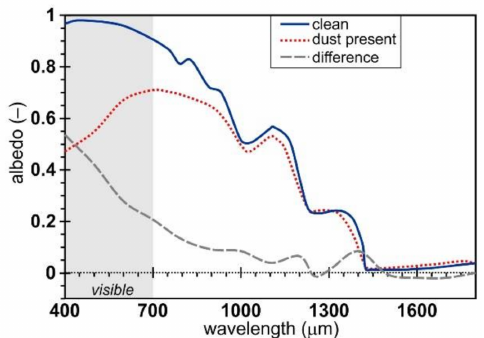
Figure 1. Clean vs. dust present albedo and the difference between the two albedos for modeled clean snow and measured snow, as a function of wavelength with a dust concentration of 0.37 mg/g (data from Painter et al.